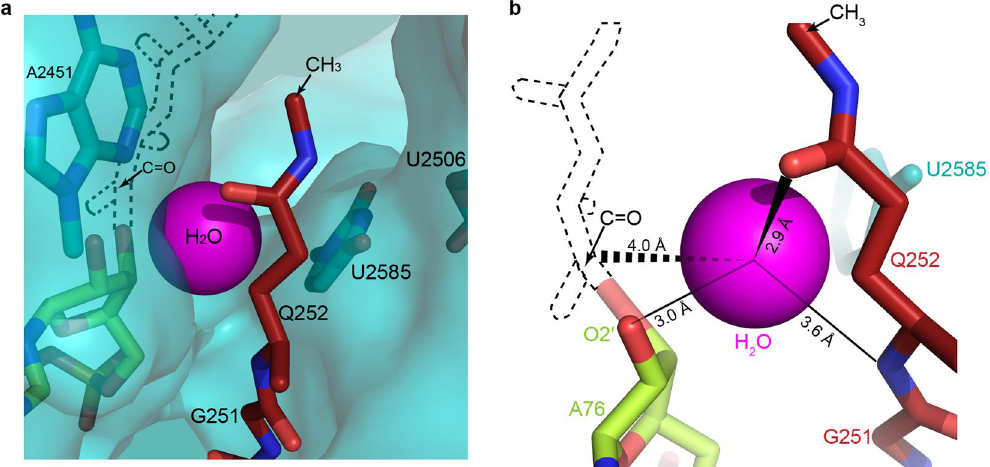
Figure 3. The catalytic pocket of the PTC in translation termination. Catalytic pocket in the PTC showing one water molecule (magenta) can be accommodated ( a ) and the catalytic water can be coordinated by the main chain NH and side chain carbonyl oxygen of Q252 and 2 ′ OH of A76 ( b ). In this way, a lone pair of electrons from the water can nucleophilically attack the carbonyl carbon in the ester bond betwee the P-site tRNA and nascent peptide for the hydrolysis reaction. Nascent peptide (dashed lines) connected with A76 was modeled according to PDB: 3J92 58 .